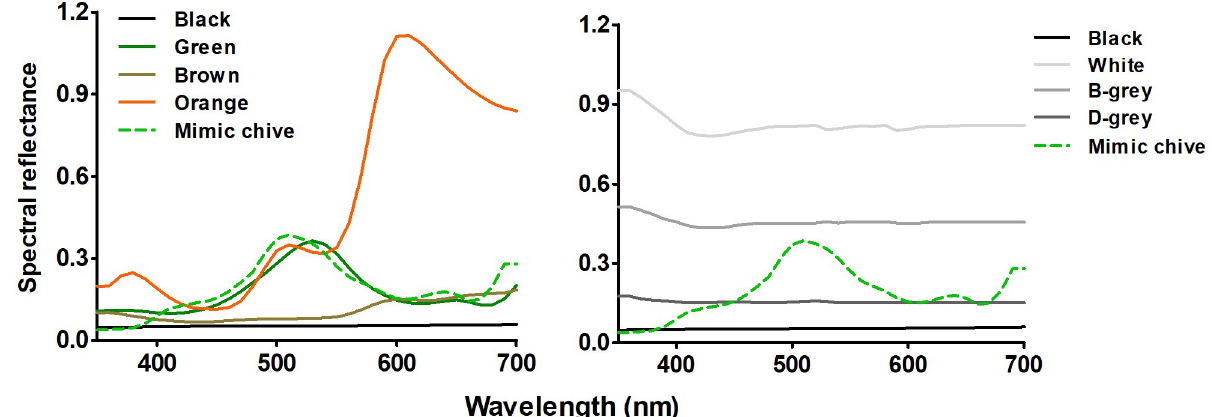
Fig 1. Reflectance spectra of all colour stimuli used in the experiments. The stimuli of colour hues were on the left; the stimuli of brightness were on the right). L-grey means light grey, D-grey means dark grey.